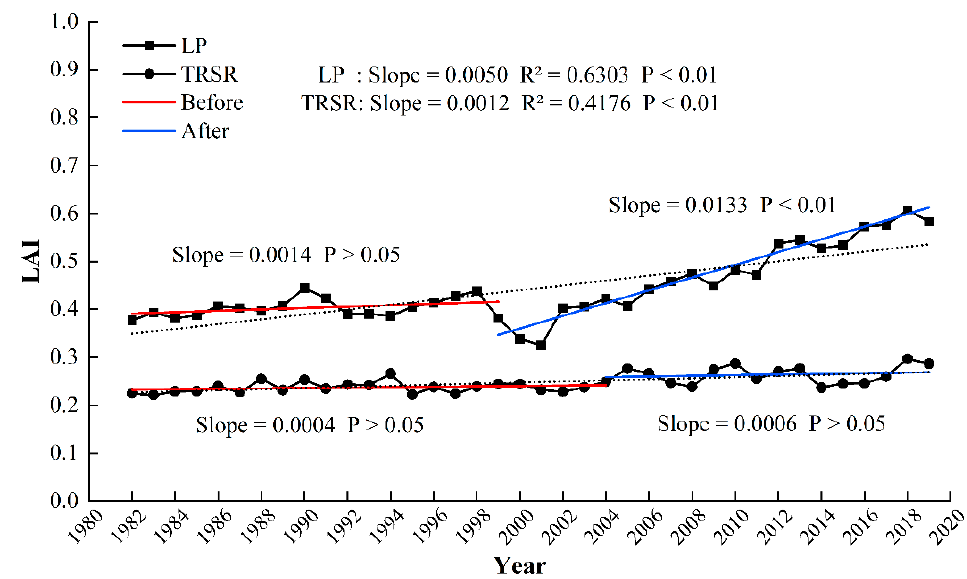
Figure 2. The trends in the LAI values over the LP and TRSR for the entire period (1982–2019); two